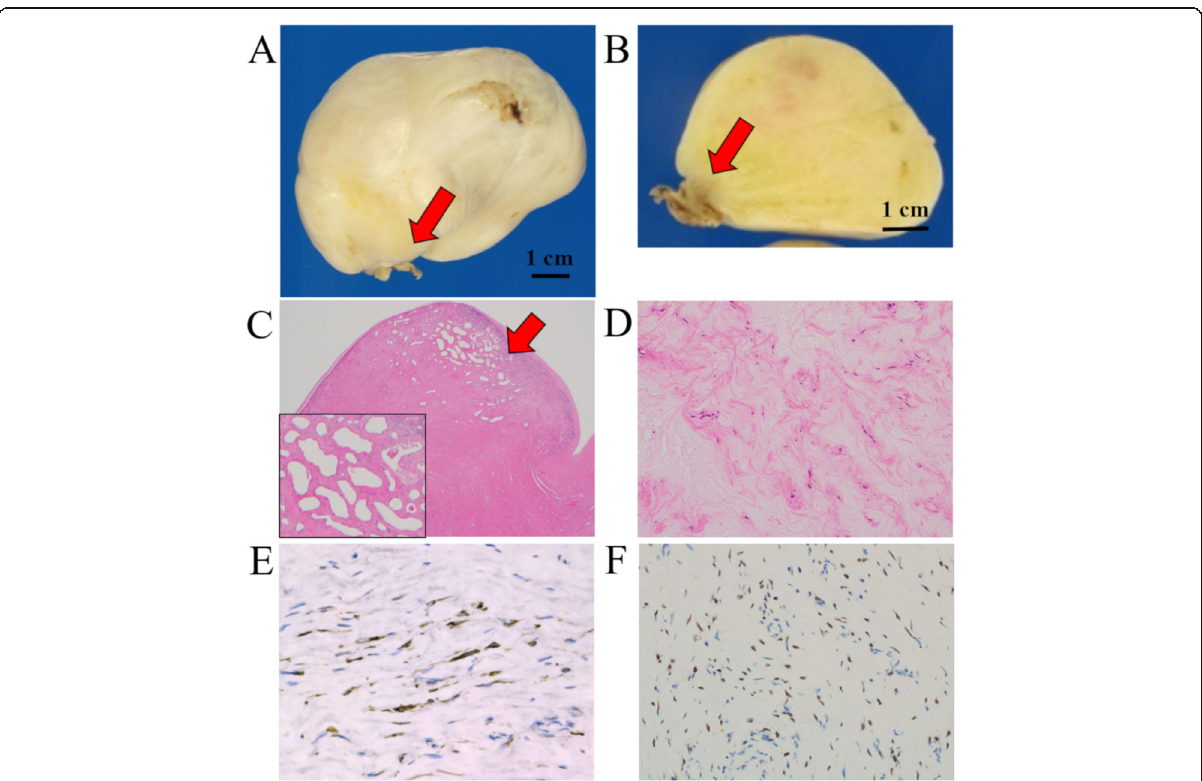
Fig. 2 The macroscopic and microscopic findings and immunohistochemical staining of the intracardiac tumor: a and b Macroscopically, the tumor was a 78 × 58 × 55-mm mass, with a pedicle (red arrows) clinging to the right atrium. b The cut surface showed a gray-white colored solid mass. c and d Microscopically, the rich microvasculature of the pedicle was shown (red arrows); d The tumor consisted of spindle-shaped cells, with eosinophilic cytoplasm, lacked atypia, and was accompanied by a myxoid change (high power view). e and f Immunohistochemically, the tumor cells were positive for ( e ) desmin and ( f )